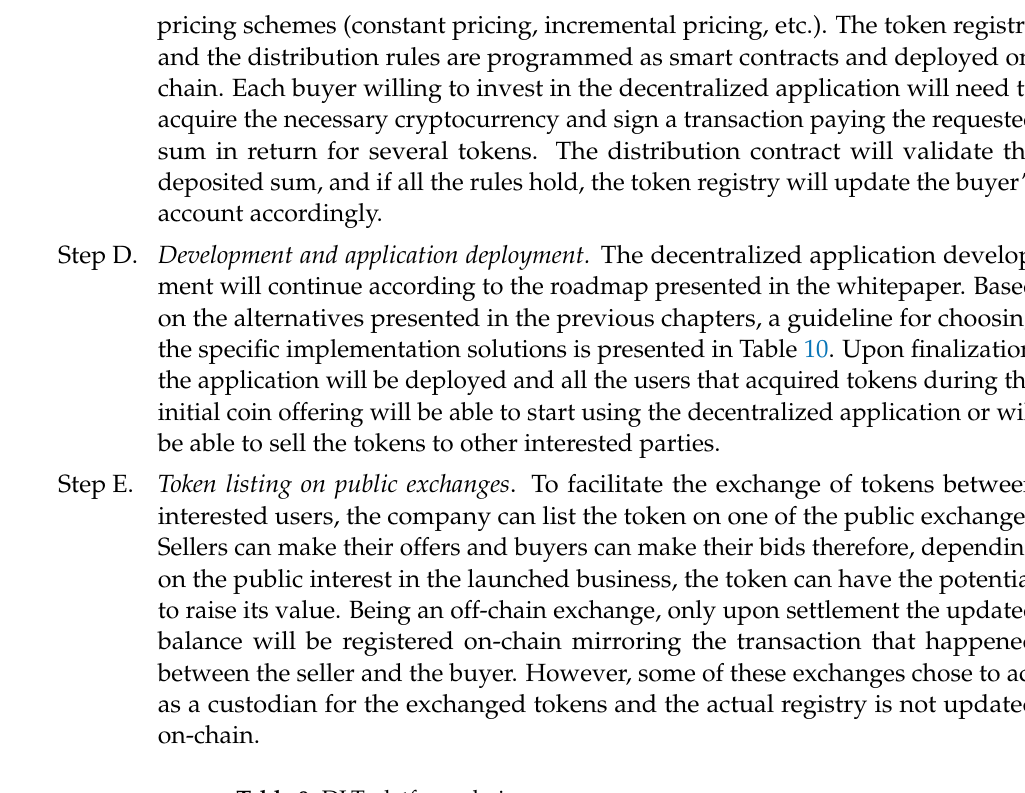
Table 9. DLT platform choice.